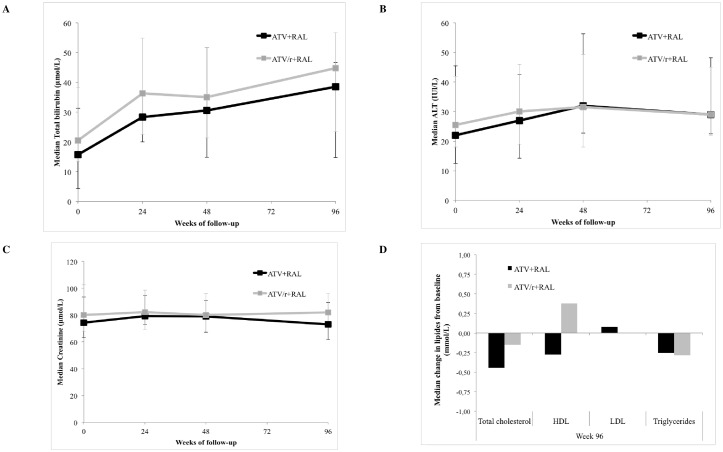
Changes from baseline in main laboratory parameters.ATV/r or ATV: Boosted or Unboosted Atazanavir; RAL: Raletgravir; ALT: Alanine aminotransferase; HDL: High-density lipoprotein; LDL: Low-density lipoprotein.